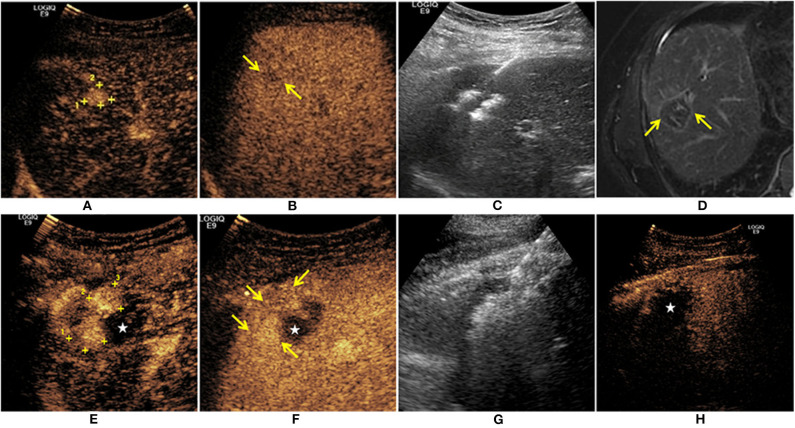
A 59-year-old man was diagnosed with HCC. The CEUS showed a single lesion (+) enhanced at arterial phase (A), and the mild washout in the lesion was found at the late phase () (B). The patient received ultrasound-guided RFA treatment (C). One month after treatment, there was no residual tumor on MR imaging () (D). Thirteen months after RFA, there were irregular nodules enhanced (+) at the upper edge of the ablation zone (★) (E). Mild washout was found at the late phase () (F). The second RFA for this recurrent HCC was performed under ultrasound guidance (G). Immediate CEUS after RFA treatment showed that there was no enhancement in the ablation zone (★) (H).